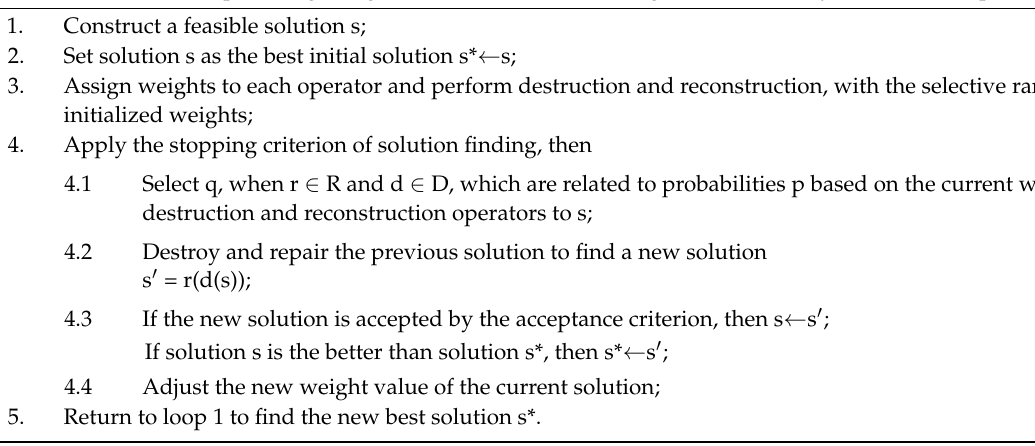
Algorithm 1. The adaptive large neighborhood search (ALNS) algorithm for family tourism route planning.